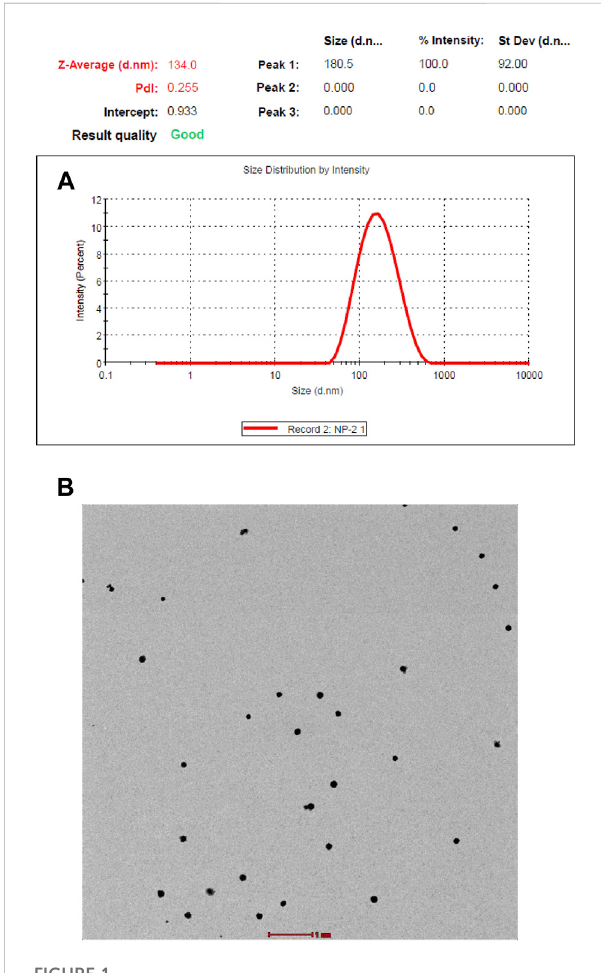
FIGURE 1 (A) Size distribution and polydisparity index of NIPAAM-VP-AA nanoparticles by dynamic light scattering (DLS). (B) Size and morphology of NIPAAM-VP-AA nanoparticles by transmission electron microscopy (TEM); scale bar = 1